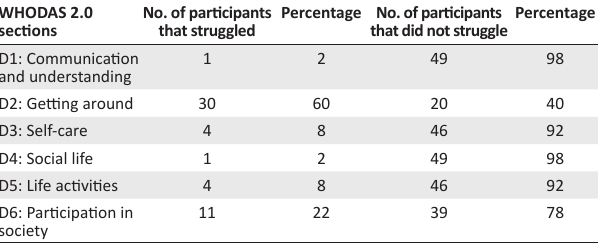
results. WHODAS 2.0 sections